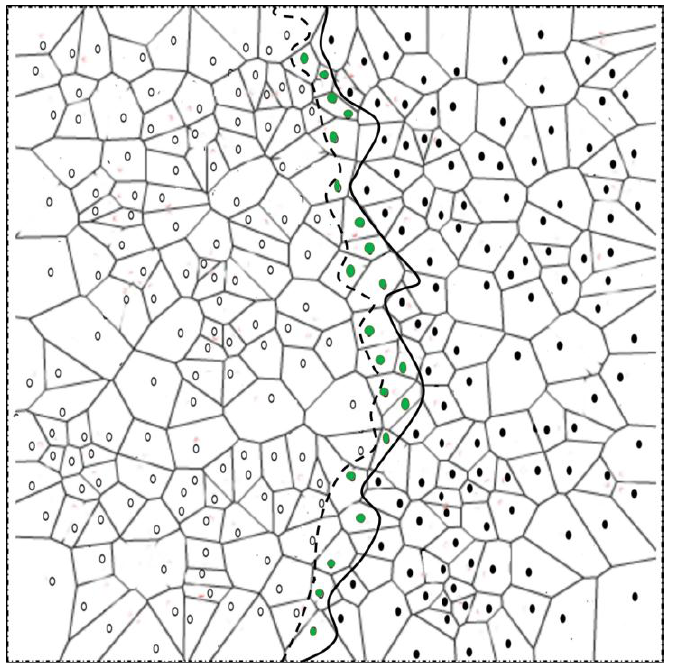
Figure 5. Change in phenomenon shape is negligible. Only normal BNs are developed. This trivial information is negligible and, thus, need not be sent to the sink to save network